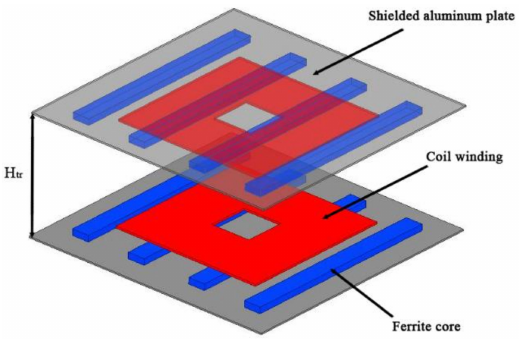
Figure 7. Overall structure of the rectangular structure transformer in 3-D.